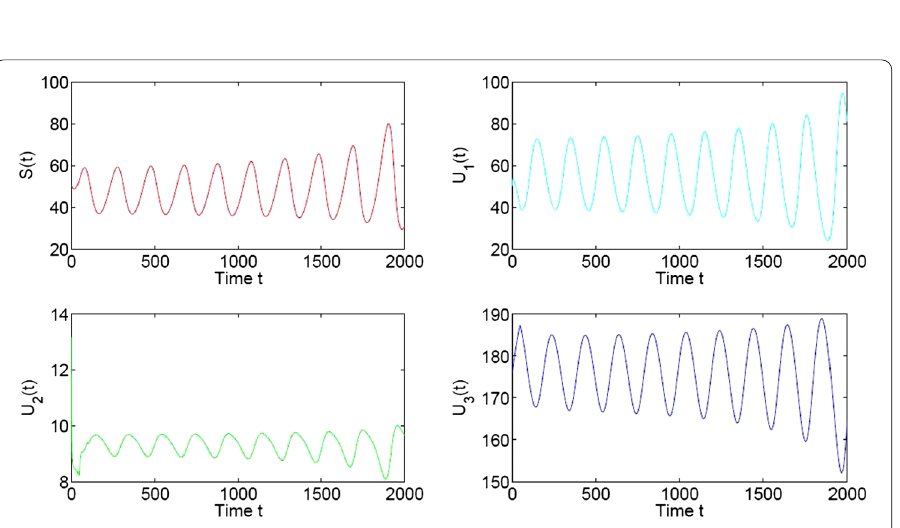
Figure 3 Time plots of S , U 1 , U 2 and U 3 with τ = 45.25 > τ 0 = 40.1285